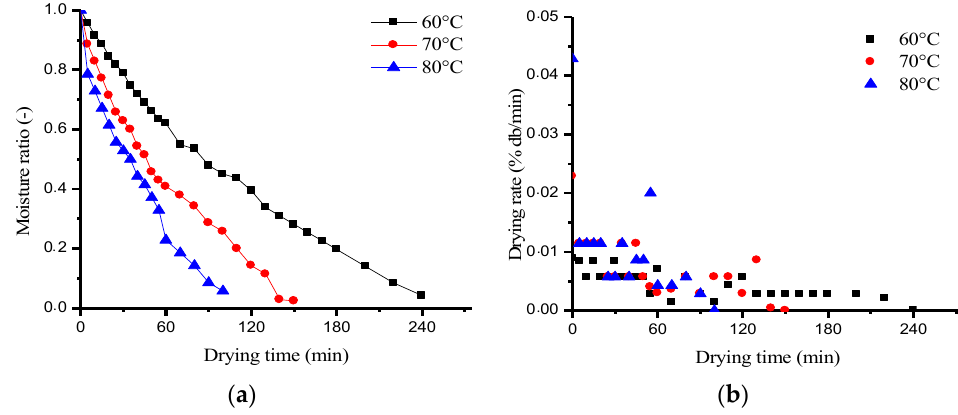
Figure 3. The trend of the moisture ratio ( a ) and drying rate ( b ) with drying time at 60 °C, 70 °C, and 80 °C.